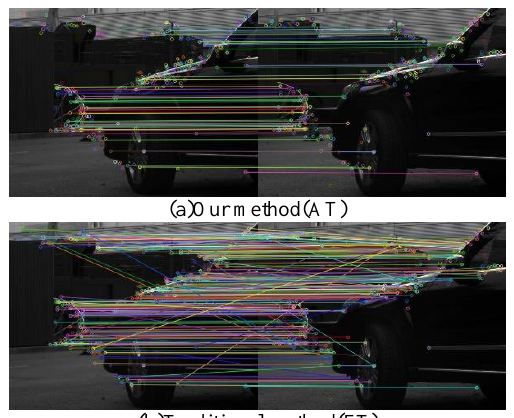
Fig. 6 The comparison between using the AT and the larger FT. (a) Matching result with AT = 0.375, the number of matching points is 175 and the correctly matching rate is 87.02%. (b) Matching result with FT =0.6, the number of matching points is 83 and the correctly matching rate is 74.28%.